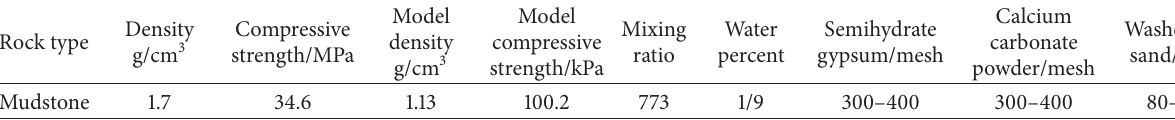
Table 1: Material mixing scheme and the size of raw material.